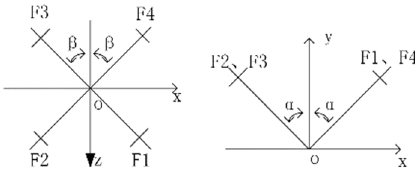
Figure 8. Configuration of the four-skewed flywheels.